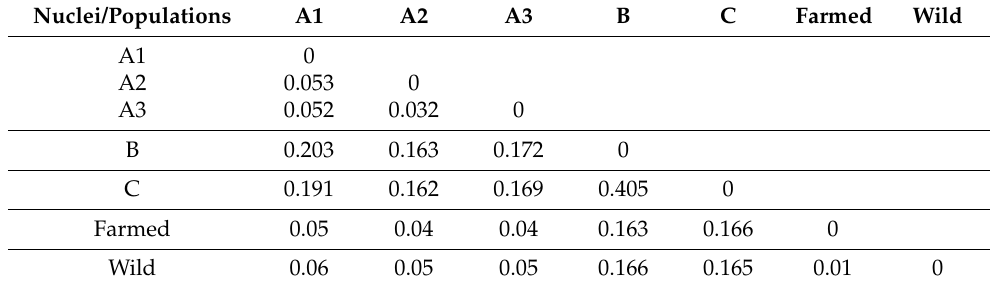
Table 2. Pairwise global F ST values for each of the groups and for the combined farmed and wild population retrieved from the previous study [7]. For further details about F ST comparisons see Table S2. Nuclei/Populations